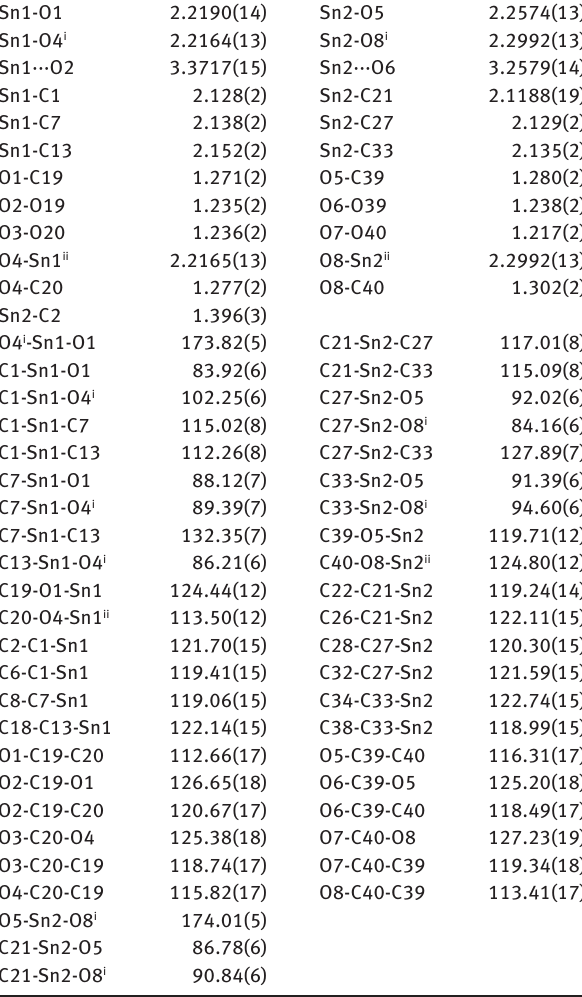
Table 2: Selected bond distances (Å) and angles ( ° ) for 1 .